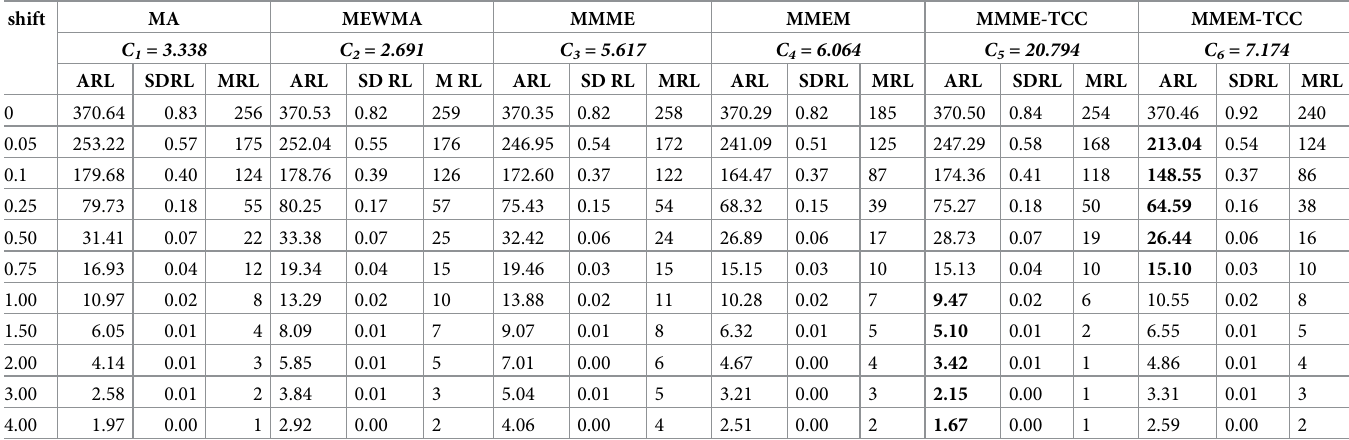
Table 3. The run length attributes of the proposed MMEM-TCC chart and existing control charts for exponential